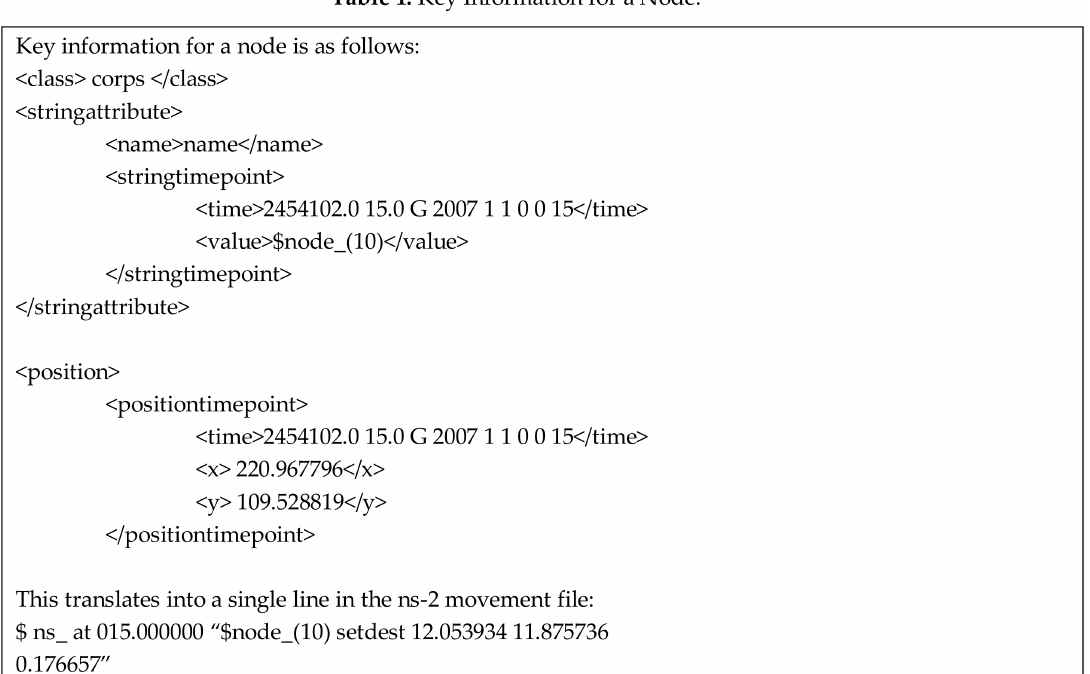
Figure 7. Conversion of Timemaps to ns-2 movement model. Table 1. Key Information for a Node.